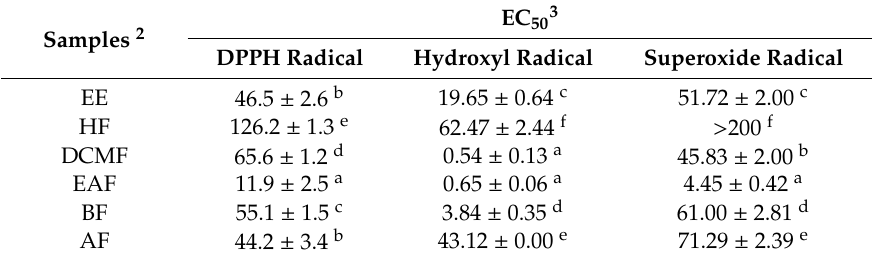
Table 3. Free radical scavenging activity of Rumex crispus L. root extracts and fractions 1